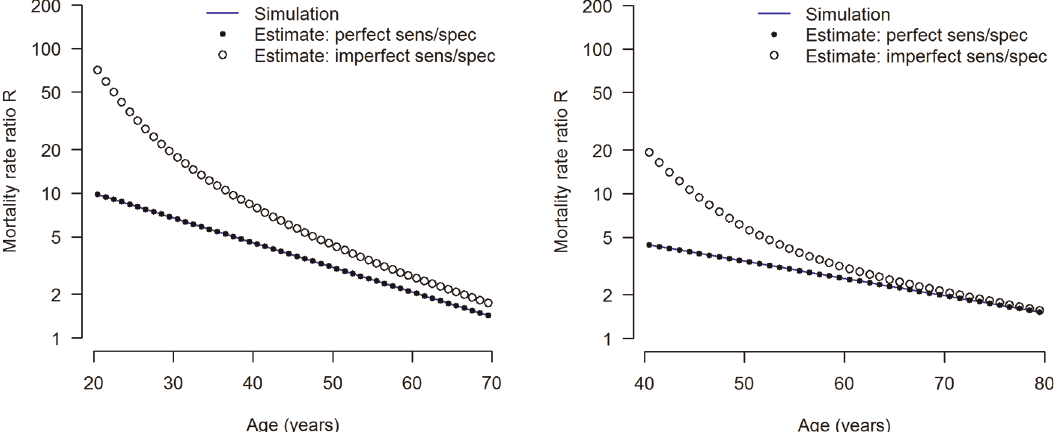
Figure2.Age-specificmortalityrateratios( R )inthesimulations. Thelowprevalenceandhighprevalencesetting are shown in the left and right panels, respectively. The input values are shown as blue lines. Mortality rate ratios R are estimated without any (visual) difference in case of perfect sensitivity se = 100% and perfect specificity sp = 100% (solid dots). In case of imperfect sensitivity and specificity, the estimates of R are biased upward (open circles).